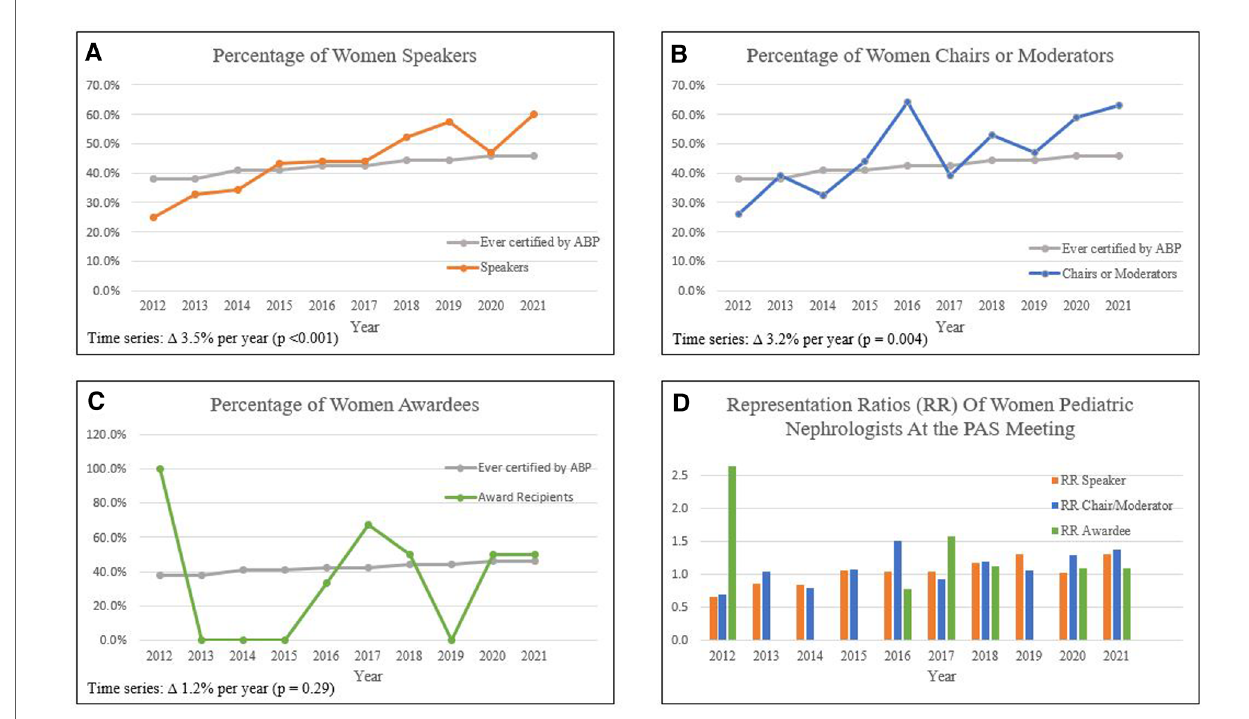
FIGURE 1 Proportion of women speakers at ASPN PAS meetings, 2012-2021. ( A ) Percentage of women speakers over time showed signi fi cant increase in 3.5% per year ( p <0.001) using time series linear regression analysis. ( B ) Percentage of women chairs or moderators increased 3.2% per year ( p =0.004). ( C ) Percentage of women awardees showed no statistically different trends over time ( p =0.29). ( D ) Representation ratios over time for speaker, chair/moderator, and awardee roles.